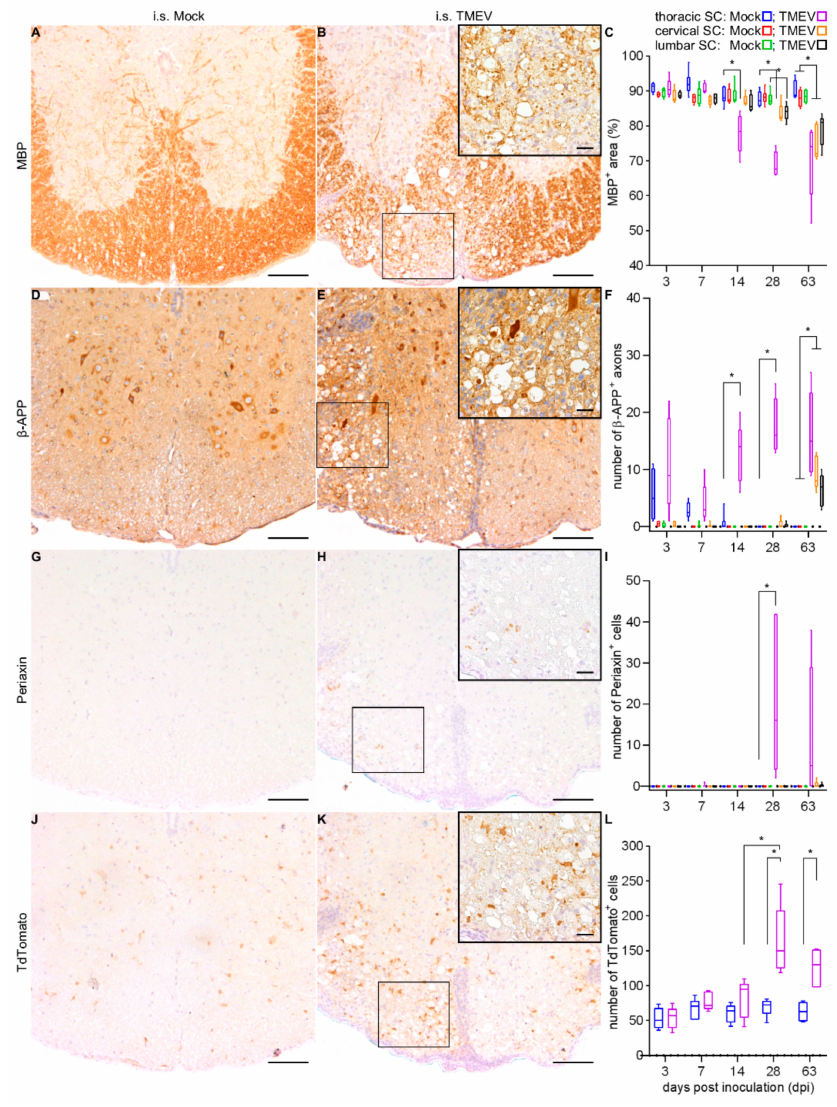
Figure 4. Detection of demyelination (myelin basic protein—MBP) and axonal damage ( β -APP) at 14 dpi within the thoracic SC following i.s. mock-injection ( A , D ) and TMEV infection ( B , E ). Characterization of regenerative attempts indicated by infiltration of periaxin + Schwann cells and TdTomato + glial cells of the NG2 lineage at 28 dpi within the thoracic SC following i.s. Mock-injection ( G , J ) and TMEV infection ( H , K ). Statistical analysis revealed significant demyelination starting at 14 dpi ( C ) and an increasing number of damaged axons ( F ), as well as a subsequent (28 dpi) increase in periaxin + and TdTomato + cells, interpreted as remyelinating attempt ( I , L ). Box-and-whisker plots show median and quartiles. Significant di ff erences between the groups as detected by a Mann–Whitney U-test are indicated by asterisks (* p < 0.05). Bars represent 100 µ m in the overviews and 20 µ m in the